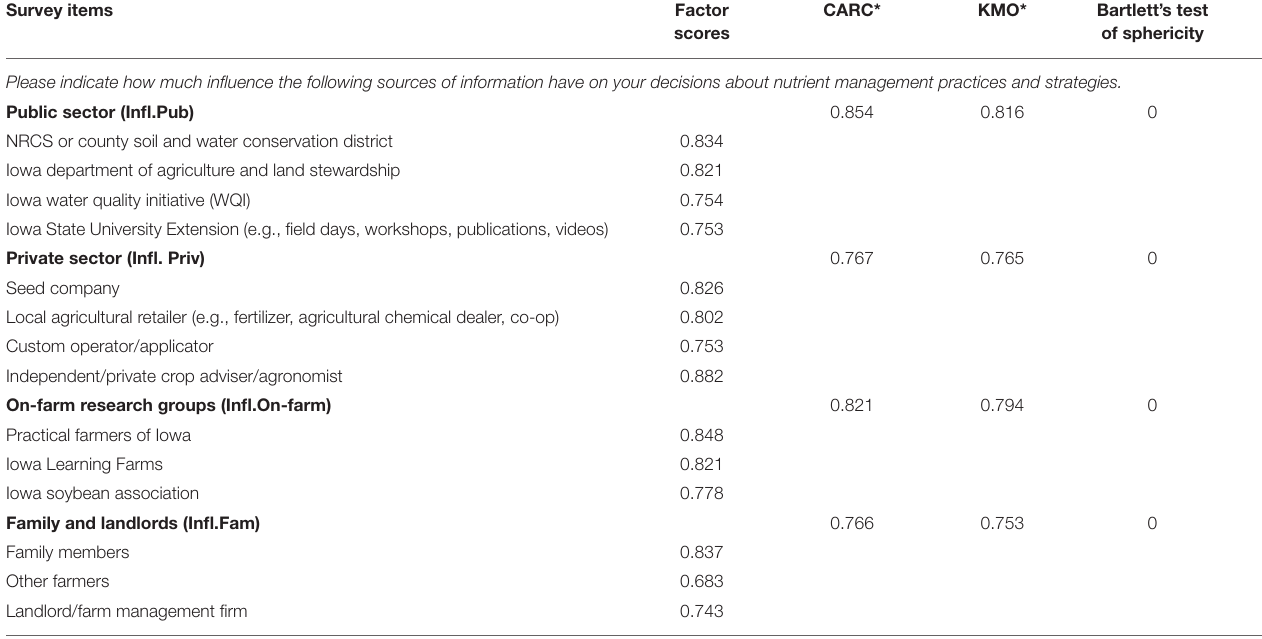
CARC* KMO* Bartlett’s test scores of sphericity